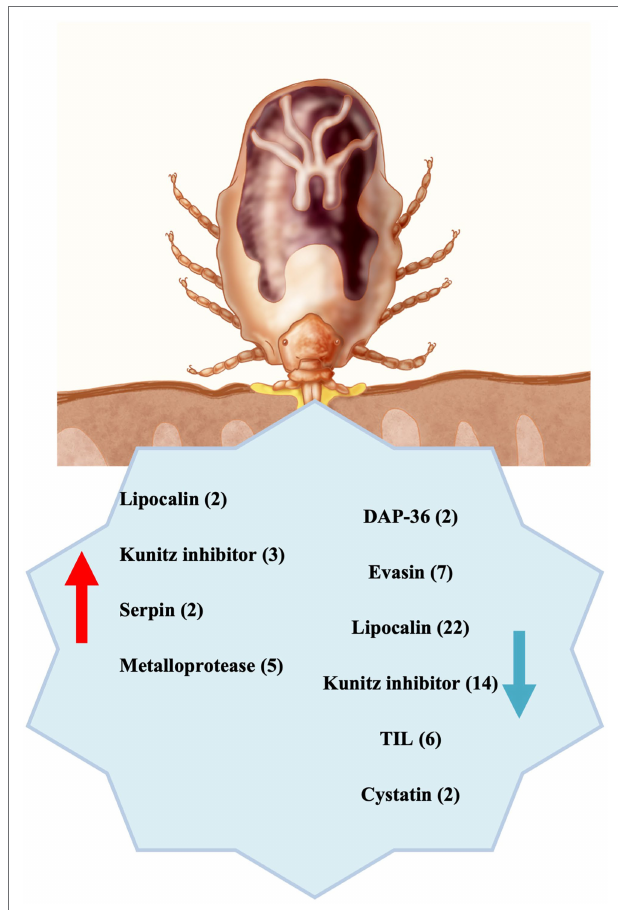
FIGURE 5 | Summary scheme: Differentially expressed transcripts underexpressed (blue arrow) and overexpressed (red arrow) in CERM ( Coxiella endosymbiont from Rhipicephalus microplus )-free metanymph were significantly involved with blood intake, suggesting that the endosymbiont is essential for building the blood feeding capacity during development. The number of transcripts from each category is indicated in the